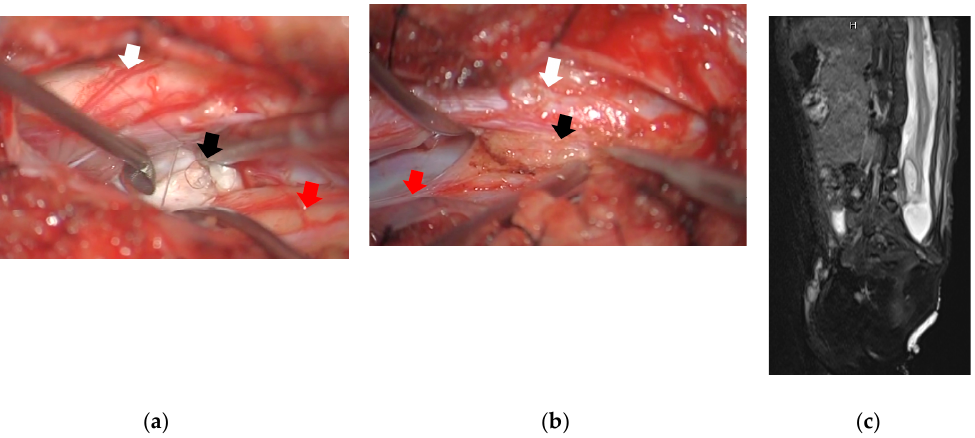
Figure 3. Surgical image and spinal MRI T2W image after surgery: ( a ) Surgical image at the rostral side of the split cord. There was a dermoid (black arrow) located at the ventral side of the atrophic right spinal cord (red arrow). Left spinal cord (white arrow) was not atrophic; ( b ) Surgical image at the caudal side of the split cord. There was a lipoma (black arrow) located at the caudal side of the atrophic right spinal cord (red arrow) attached to the left spinal cord (white arrow); ( c ) The sagittal view of spinal MRI showed the untethered lipoma and the improvement of the syrinx; MRI, magnetic resonance imaging; T2W, T2 weighted.